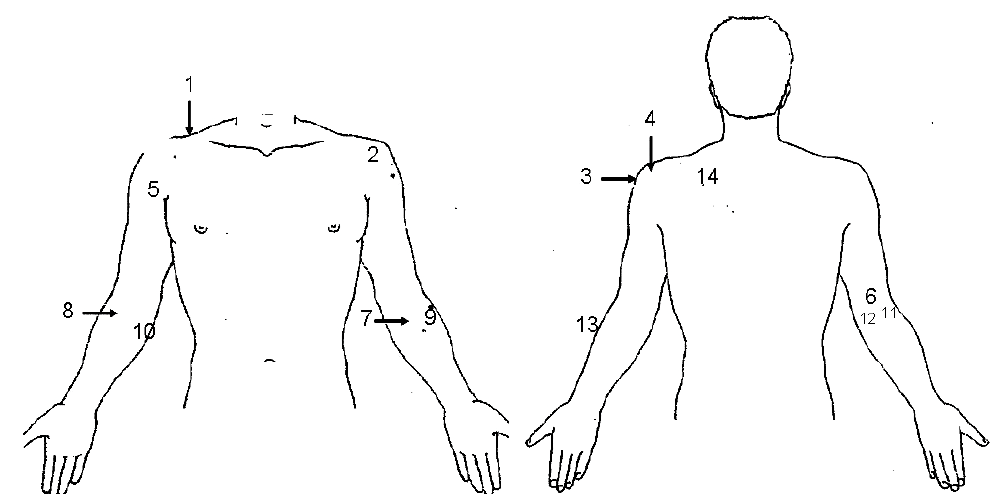
Figure 1. Anatomical sites of detection of pressure points of the upper limb. 1. First rib, 2. Rotator cuff, 3. Subacromial space, 4. Acromioclavicular joint, 5. Biceps tendon, 6. Triceps, 7. Pronator teres, 8. Radial tuberosity, 9. Ligamentum annular radii, 10. Flexor carpi ulnaris, 11. Dorsolateral capsule of the elbow, 12. Dorsomedial capsule of the elbow, 13. Extensor carpi radialis, 14. Levator scapula.